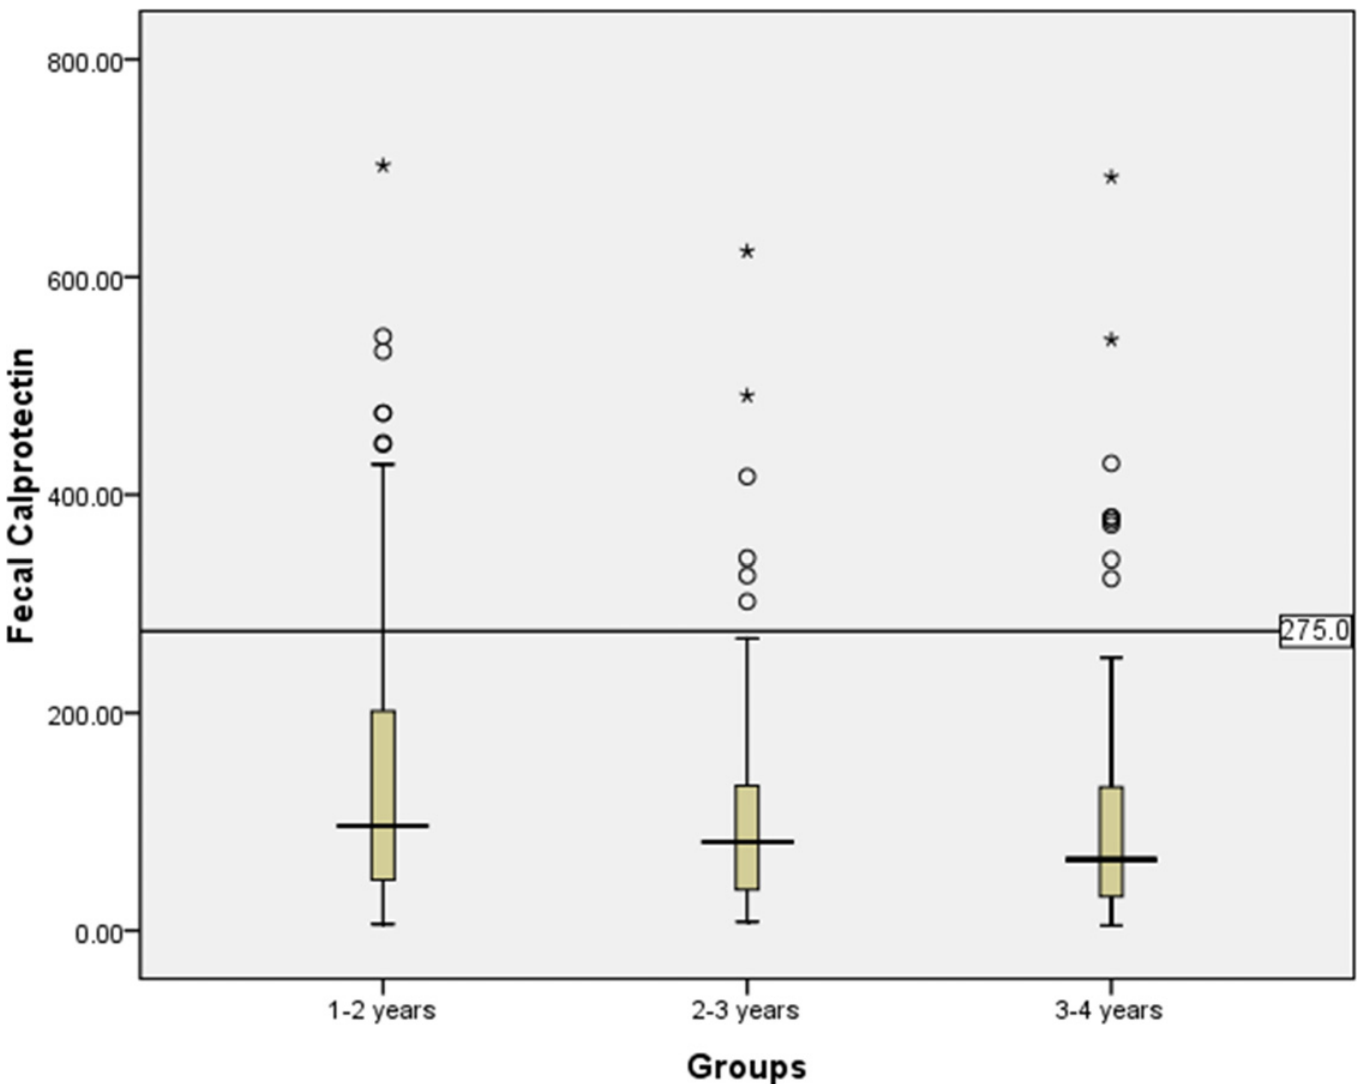
Fig 1. Fecal calprotectin concentrations in three age groups of healthy